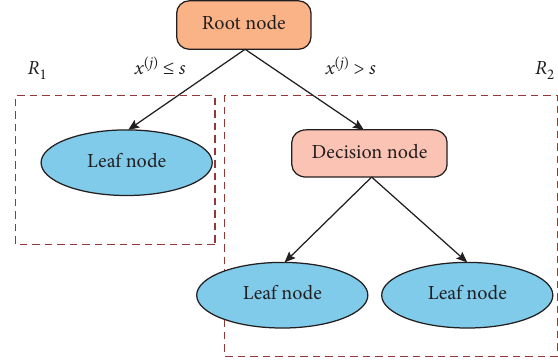
Figure 1: Schematic of